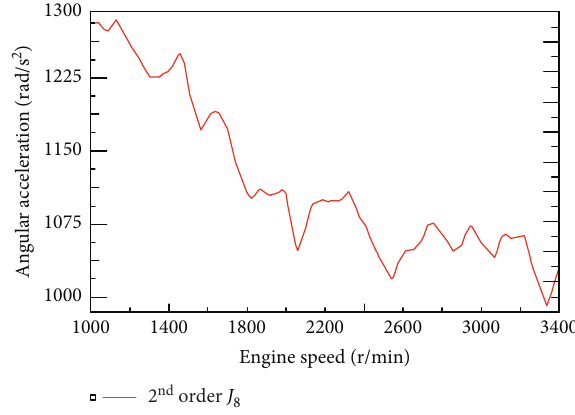
Figure 34: The 2 nd order angular acceleration curve of the primary flywheel matching with the bifilar CPVA under driving conditions.